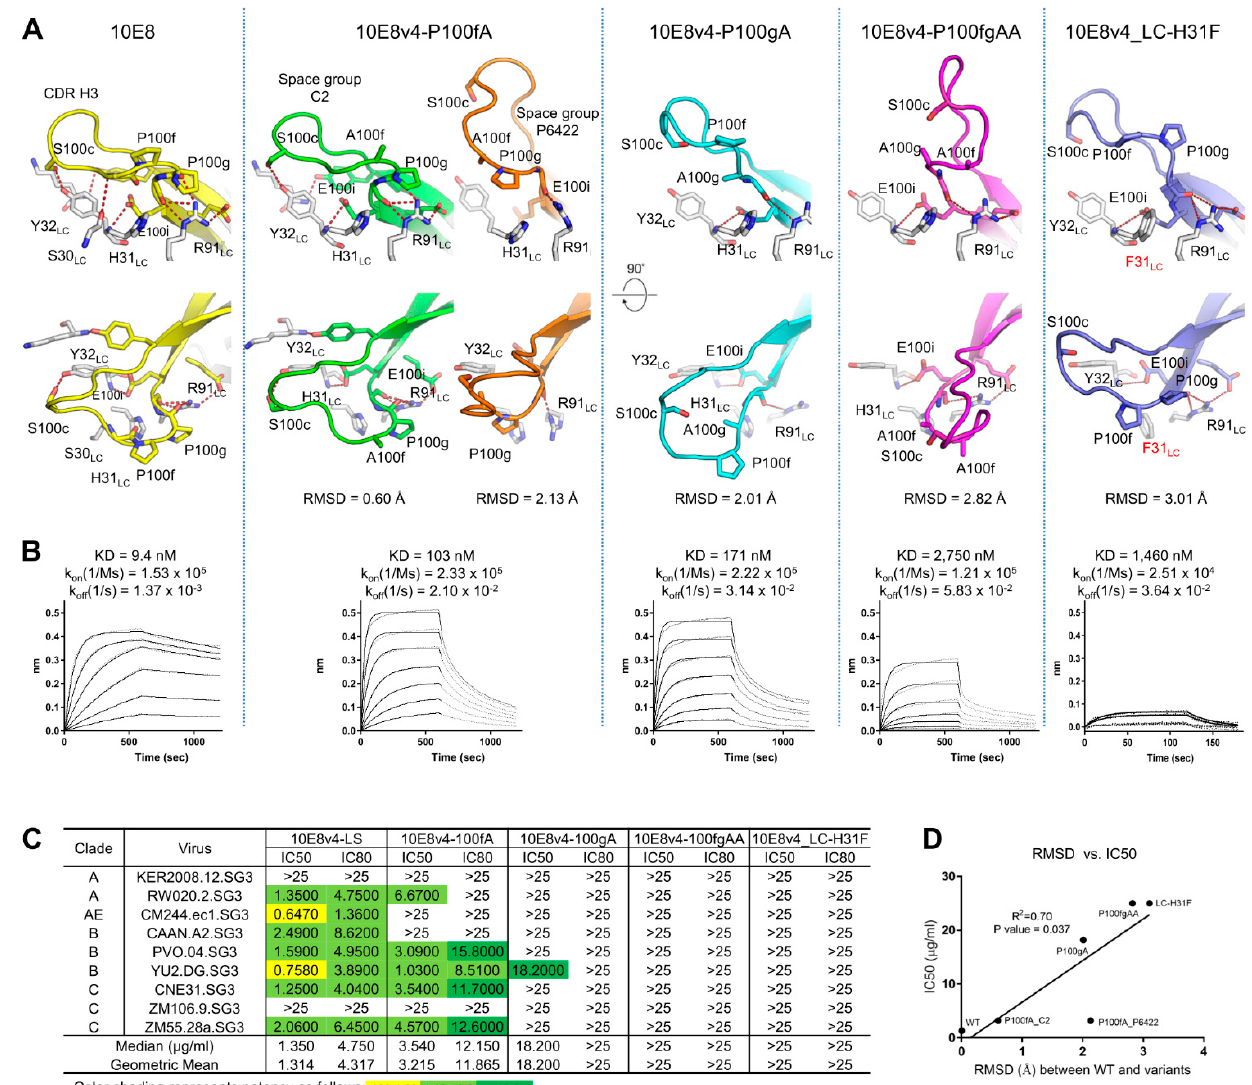
Figure 5. Active conformation similarity of 10E8 variants involving CDR H3 di-proline motif mutants or motif-interacting residues correlates with neutralization potency. ( A ) Different conformations of the CDR H3s were shown with RMSDs of C α between the variants and 10E8 structure. Hydrogen bonds between the residues in the CDR H3 and the light chains were shown in dotted lines. ( B ) Binding kinetics of Fab molecules of 10E8v4 variants to T117-F MPER scaffold measured by BLI. ( C ) Neutralization potency and breadth of 10E8v4 variants against select viruses. ( D ) Correlation between RMSD and median IC50.